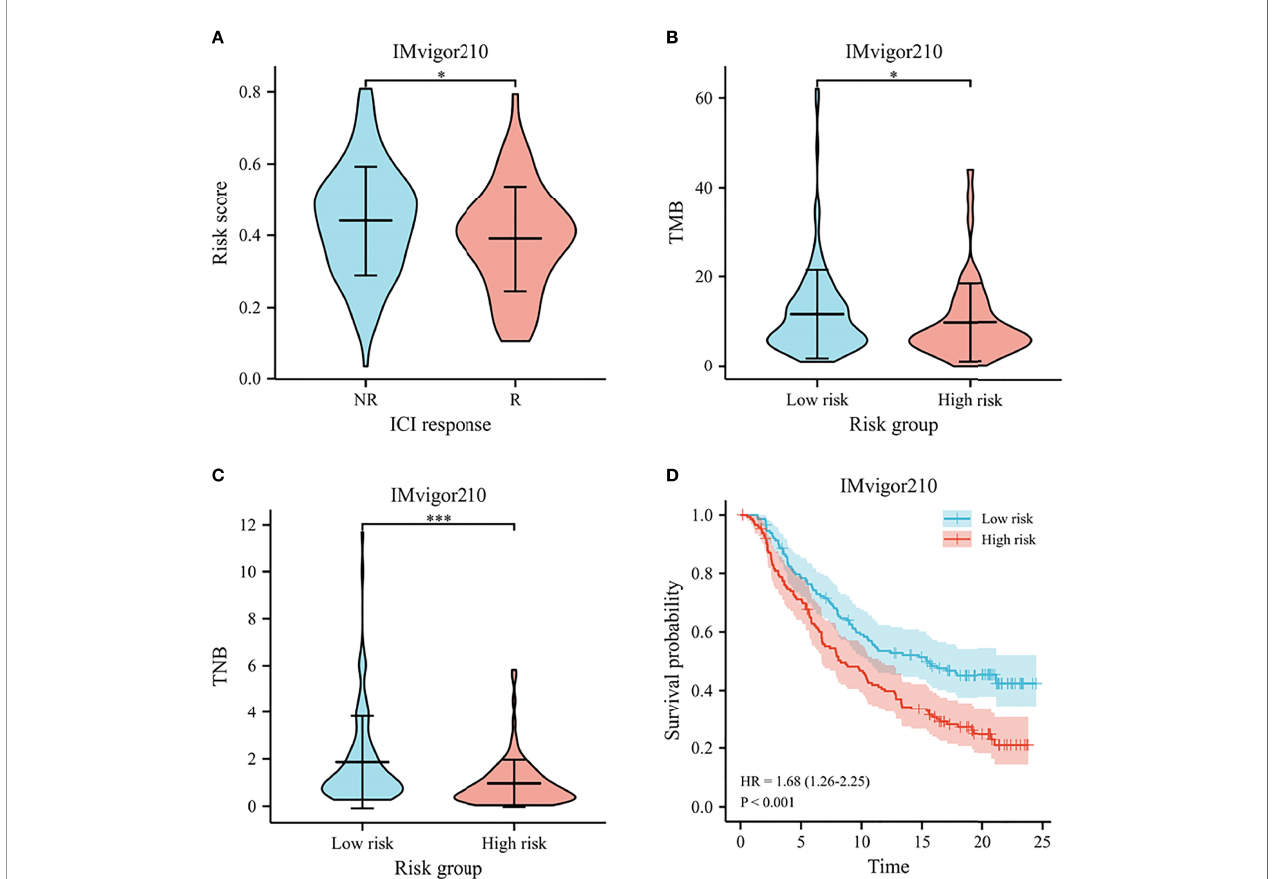
FIGURE 11 | Immunotherapy response in IMvigor210. (A) The violin plot for risk scores between responders and non-responders to immunotherapy. (B) The violin plot for TMB between high- and low-risk groups. (C) The violin plot for TNB between high- and low-risk groups. (D) Survival curves of predicting the OS using risk score. *p < .05, and *** p <